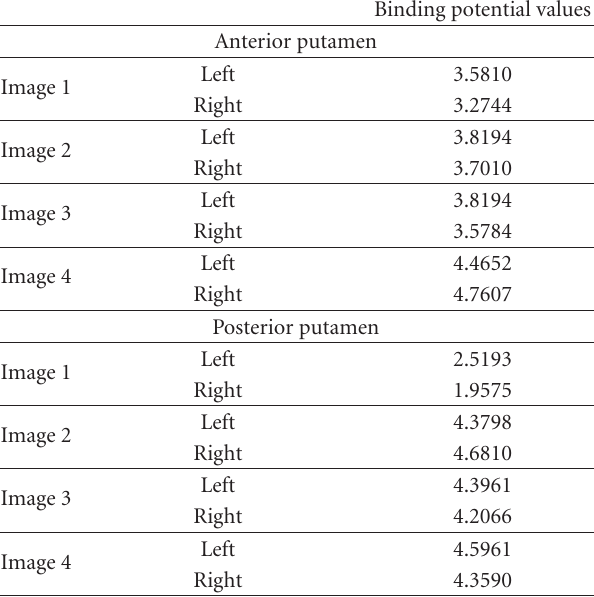
Table 3: BP ND values from anterior and posterior putamen from all 4 HRRT PET